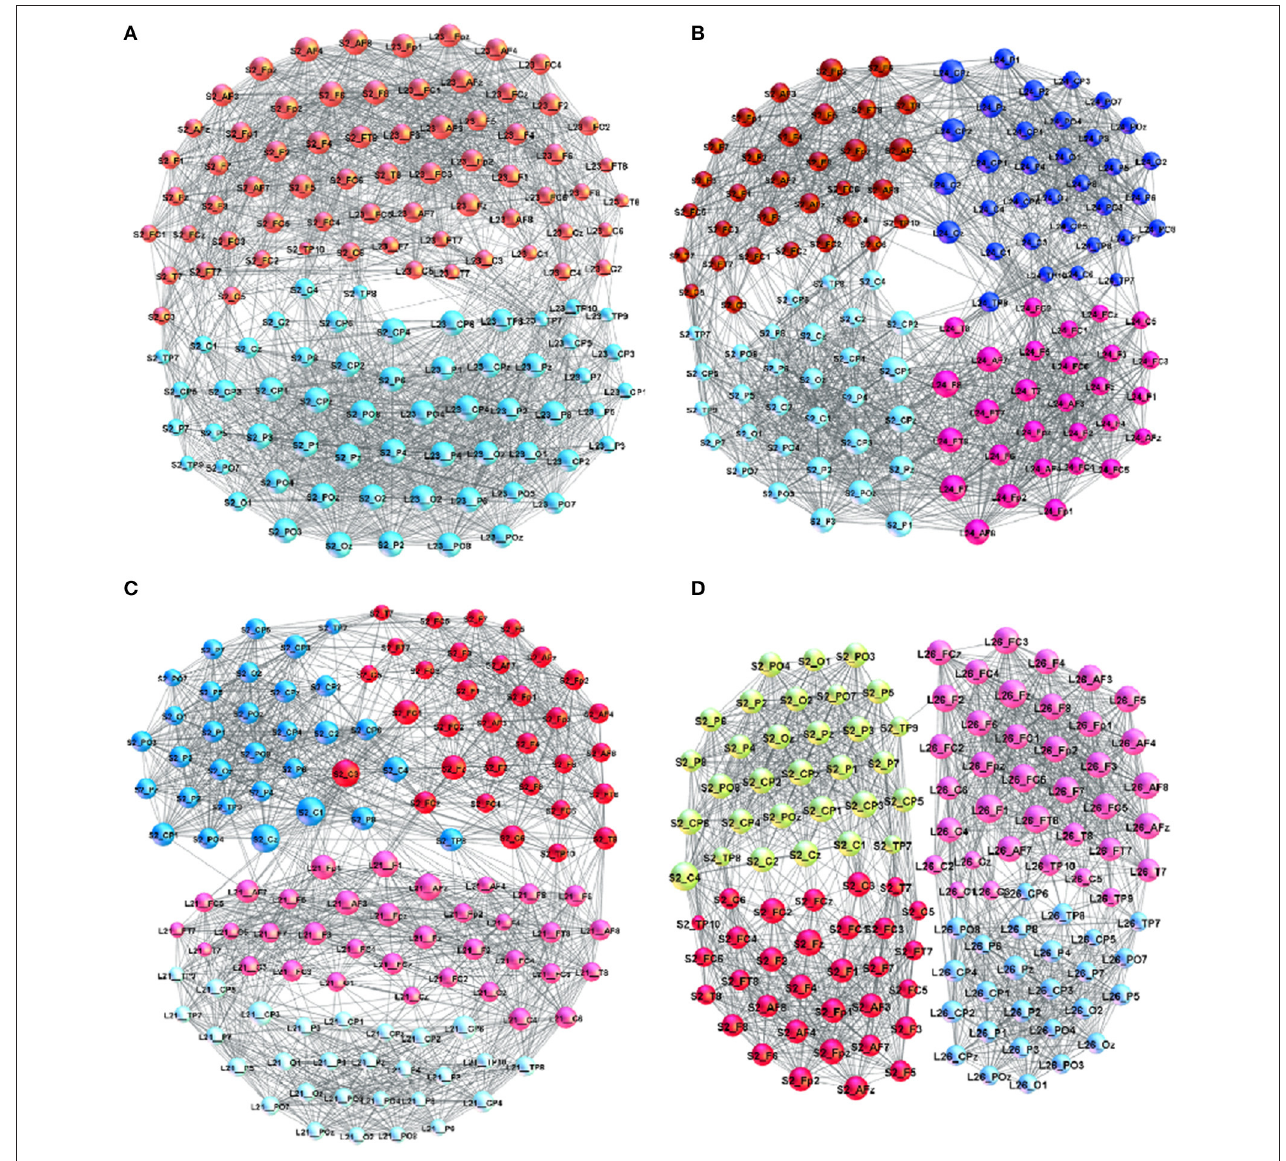
FIGURE 3 | Examples of brain-to-brain coordination networks with a “good” speaker (speaker S 2 ) and (A) L 23 (superbrain community structure), (B) L 24 , (C) L 21 , and (D) L 26